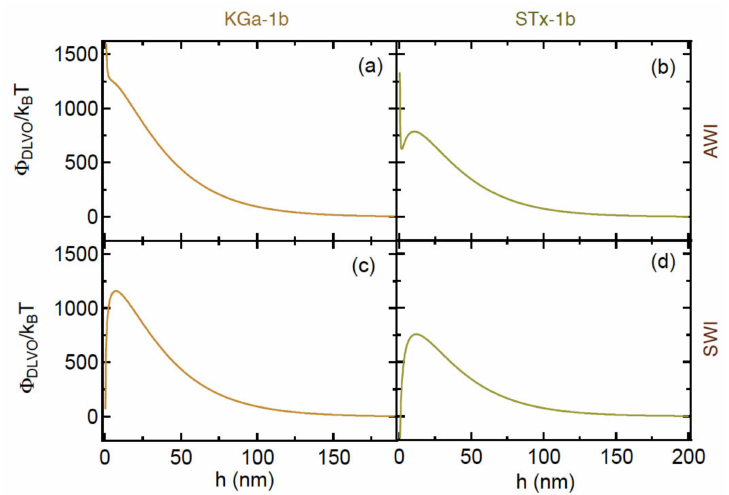
Figure 5. Predicted DLVO energy interactions as a function of separation distance, based on sphere-plate model for: ( a ) (KGa-1b)-AWI, ( b ) (ST x -1b)-AWI, ( c ) (KGa-1b)-SWI, and ( d ) (ST x